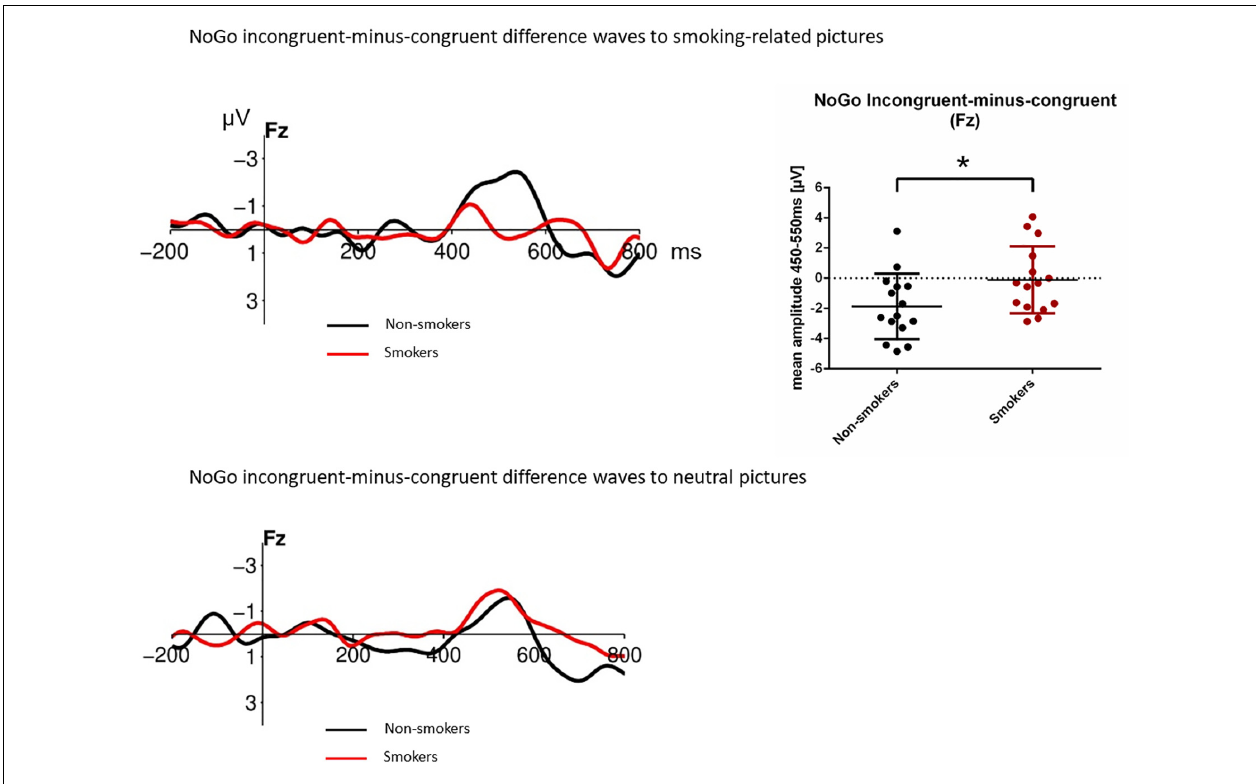
FIGURE 4 | NoGo incongruent-minus-congruent difference waveforms in non-smokers and smokers to smoking-related pictures (top) and neutral pictures (down) at Fz. Note that the mean amplitude at 450–550 ms differs significantly between groups when smoking-related pictures are presented, while no difference between groups is observable after the presentation of neutral pictures. The displayed waveforms were filtered with a 12 Hz low-pass filter. * p <